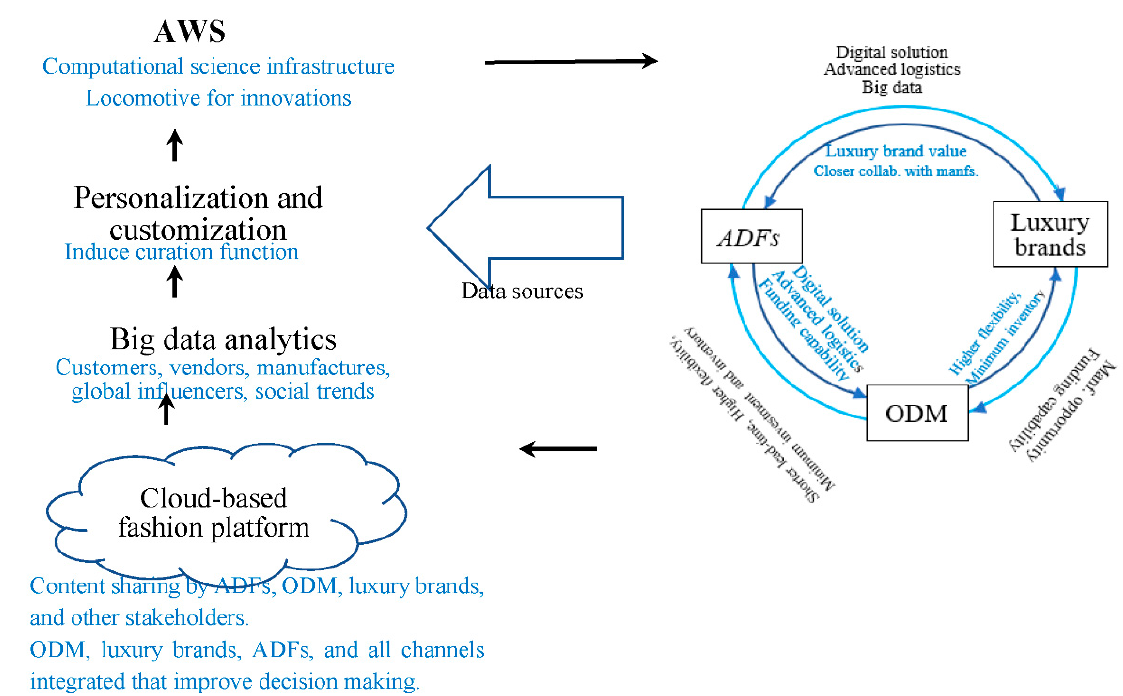
Figure 14. Dual co-evolution Among ADFs, luxury brands, ODM co-evolution, and cloud-based fashion platform advancement.